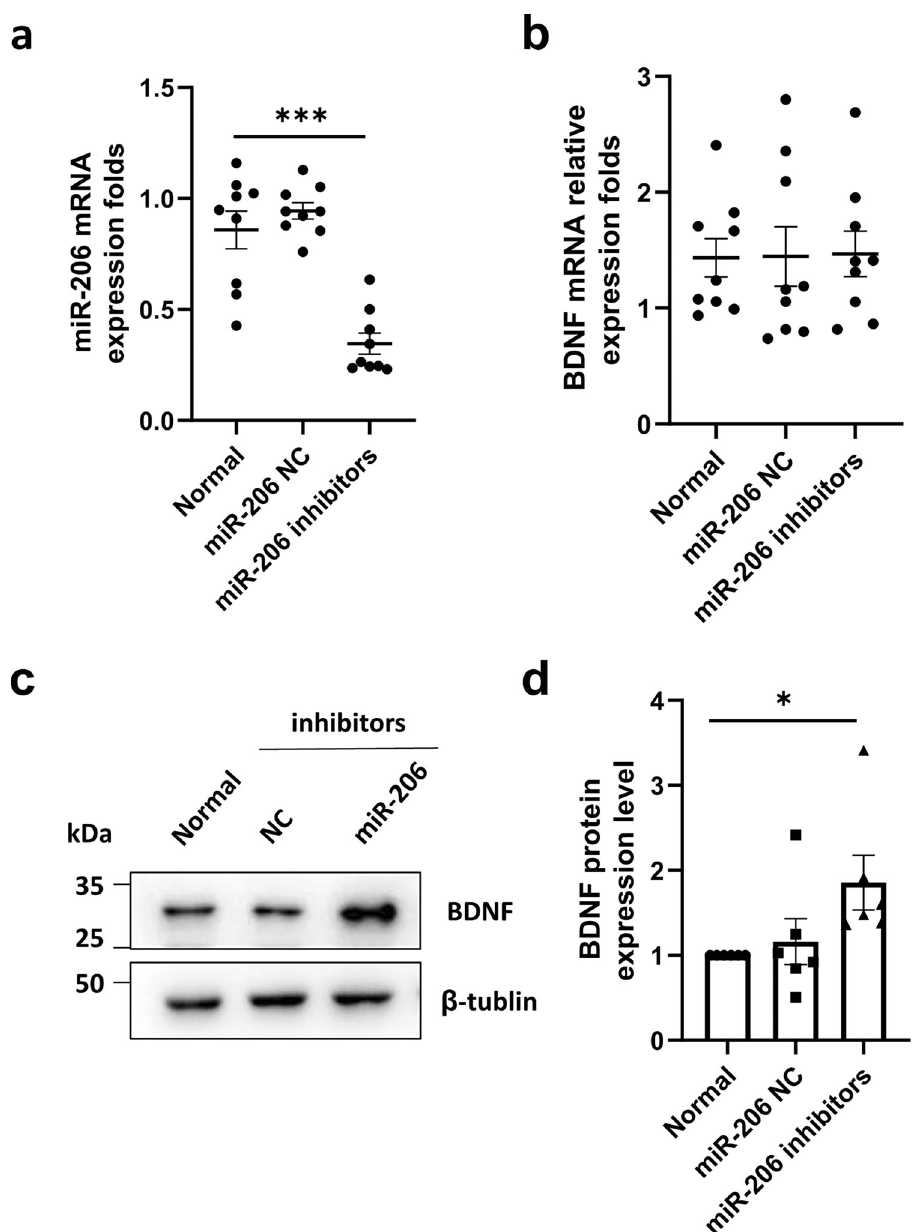
Fig. 4 Relationship between miR-206 and BDNF. a After the transfection of hUCMSCs with miR-206 inhibitor, the expression level of miR-206 mRNA was detected by RT-qPCR. b After transfection with miR-206 inhibitor, the expression level of BDNF mRNA was detected by RT-qPCR. c After transfection of hUCMSCs with miR-206 inhibitor, the expression level of BDNF protein was detected by western blot. d Quantitative analysis of the protein levels of BDNF. The results were expressed as the Mean ± SD, * p < 0.05, versus normal groups, n = 6. consider that miR-206 may improve aging cognition through down-regulated after D-gal induced senescence, then up- the BDNF/TrkB/CREB signaling pathway by targeting BDNF in D- regulated after treated hUCMSCs with lower miR-206. There- gal-induced aging mice. fore, we think that hUCMSCs with down-regulated miR-206 In our study, the tracing of stem cells in the brain showed no have a better neuroprotective effect by targeting BDNF in D- cells in the lateral ventricle after 10 days. We also tested three gal-induced aging mice. short-term memory behavioral experiments related to episodic Upstream CREB regulates Egr-1. When p-CREB, the activated and spatial learning. However, it is also necessary to explore long- form of CREB, is continuously enhanced in the hippocampus, term learning and memory ability of cognitive ability, which can the expression of downstream Egr-1 will be promoted, thus be explored by other related behavioral tests in future studies. In affecting learning and memory ability [31]. CREB is a key addition, we showed that miR-206 targets BDNF to improve transcription factor in the activation signal of TrkB, which is the cognitive decline by exploring key intermediate molecules binding receptor of BDNF. Upregulation of BDNF/TrkB/CREB this associated with the signaling pathway, suggesting further studies classic neuroprotective pathway signaling inhibits neuronal on the regulation mechanism of its internal signal pathway. apoptosis in neurodegenerative diseases [32]. Therefore, we Cell Death Discovery (2022)